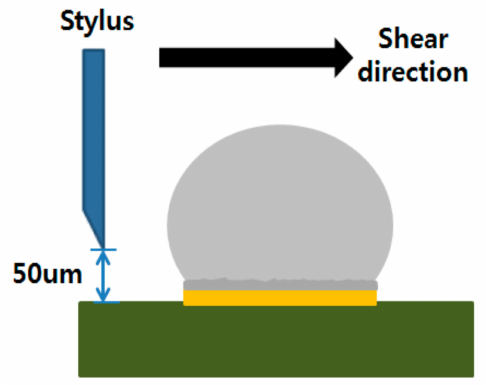
Figure 2. Schematic illustration of solder ball shear